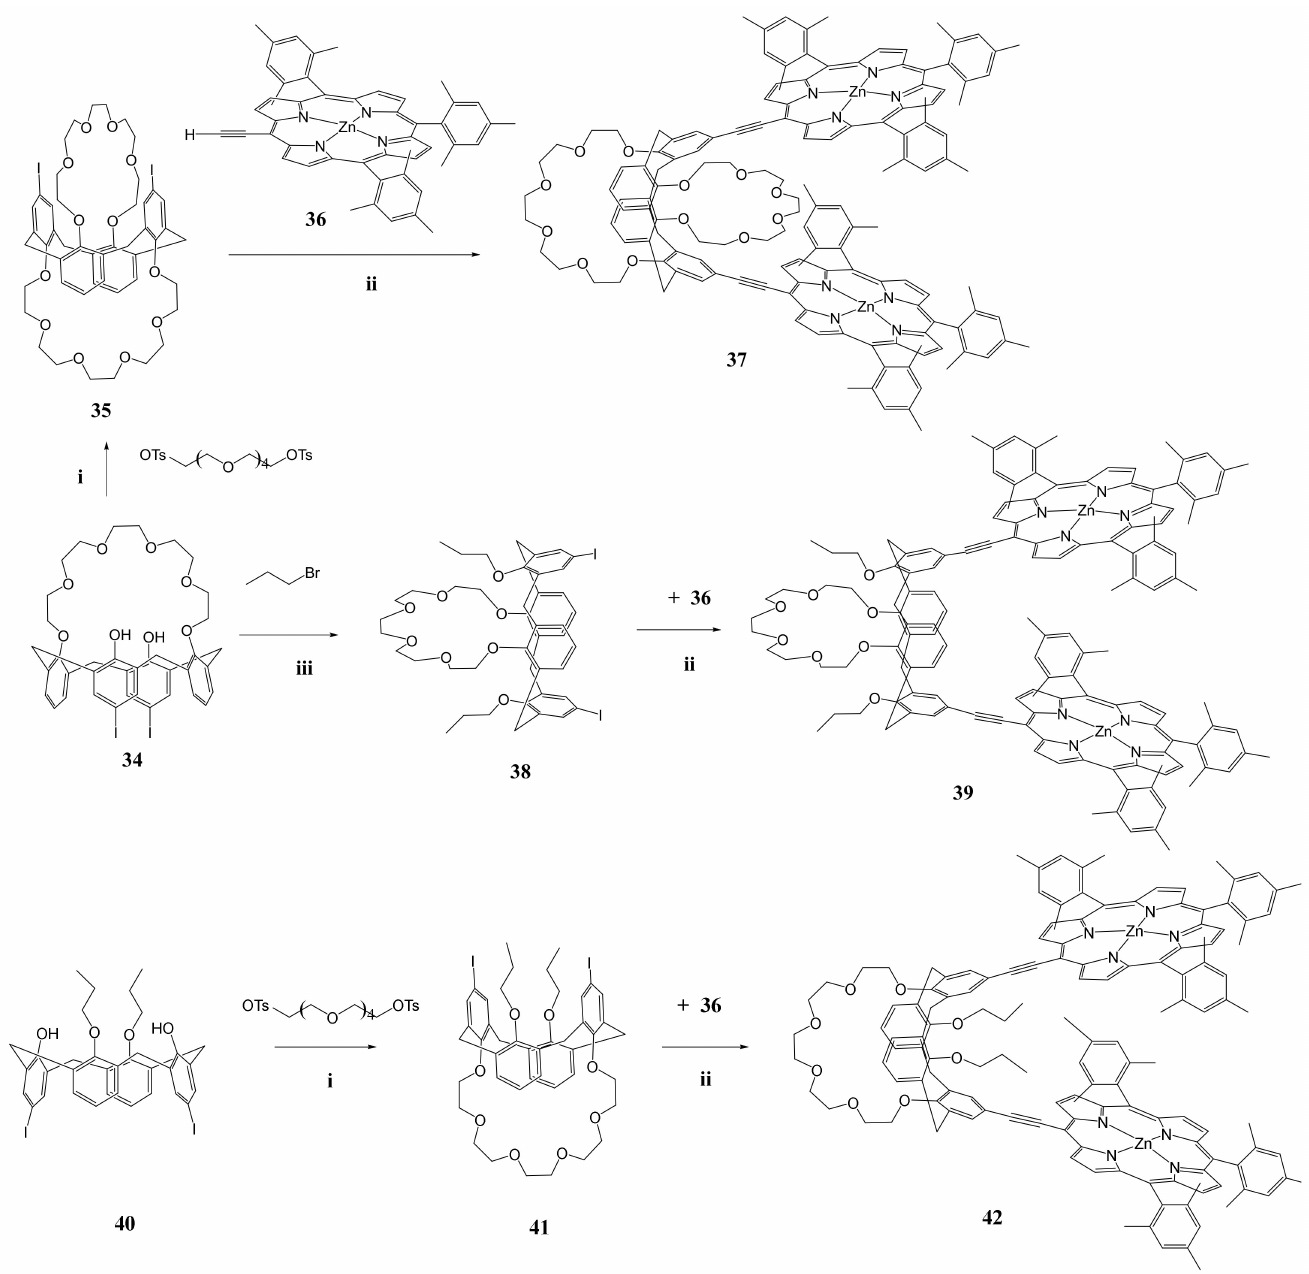
Scheme 9. Conditions of synthesis of the porphyrin-calixarenes 37 , 39 and 42 : ( i ) Cs 2 Co 3 , CH 3 CN, reflux; ( ii ) 10% Pd(PPh 3 ) 2 Cl 2 , CuI, Net 3 , 323K; ( iii ) NaI, DMF, 298